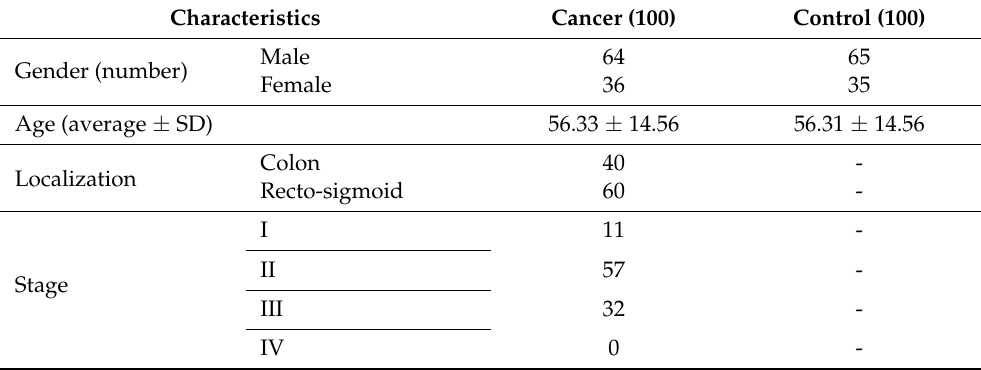
Table 1. Demographic and main clinical data of CRC patients and control used for SNPs